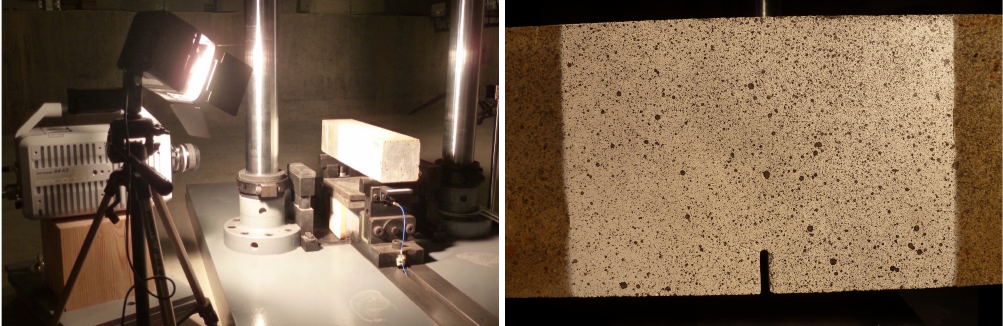
Figure 6. The experimental setup with the high-speed camera ( left ), and the speckle pattern obtained from black/white paint using air spray ( right